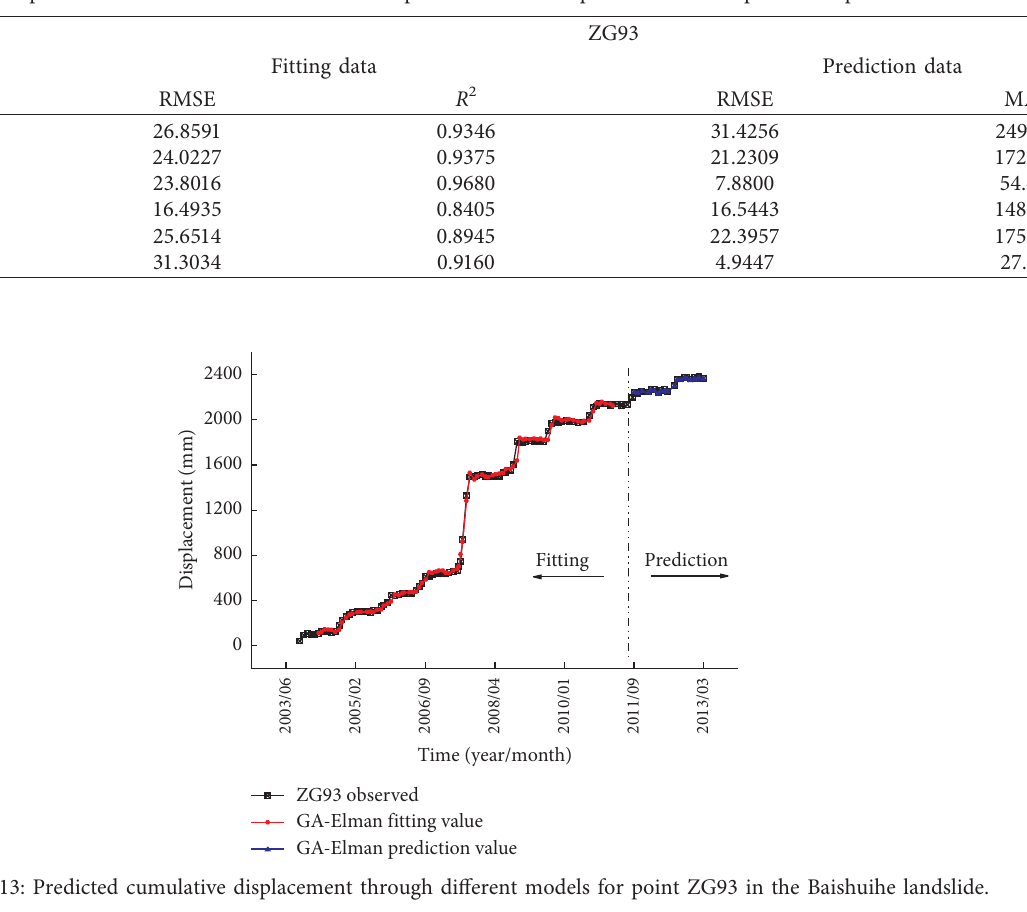
Table 2: Comparisons of the evaluation indicators on point ZG93 of the periodic trend displacement prediction